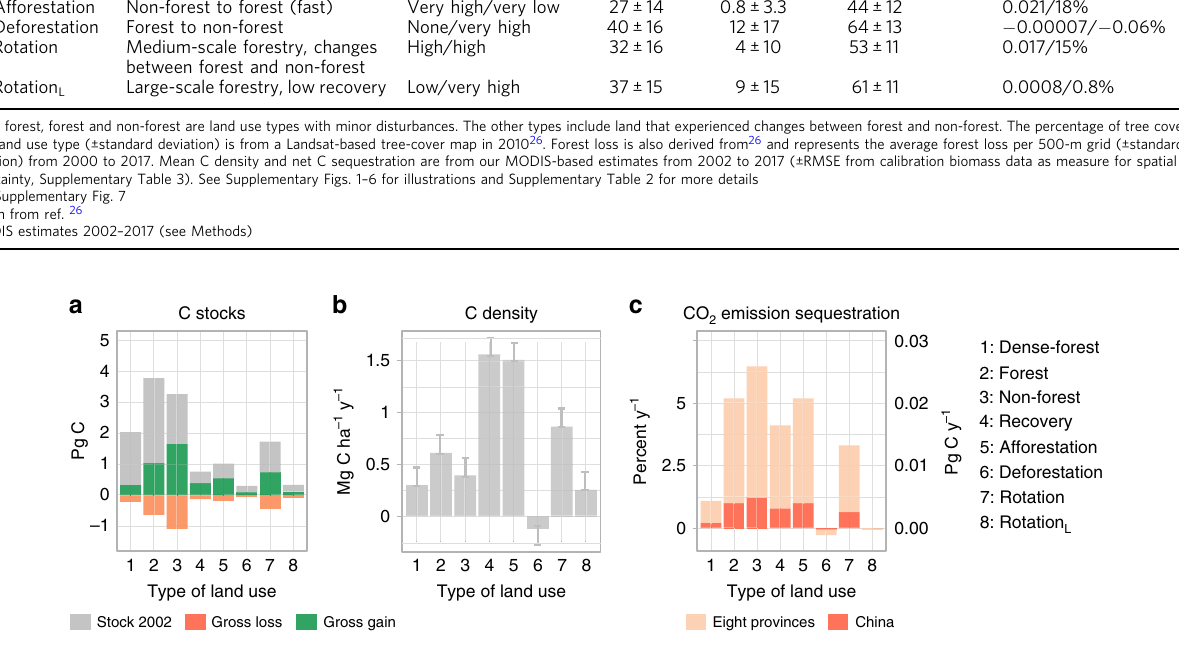
Fig. 3 Dynamics of carbon stocks for different types of land use. a C stocks estimated from MODIS data are shown for the fi rst year of study in 2002 in grey, with consecutive gross gains and losses for 2002 – 2017 in green and orange, respectively. b Net changes in C density (2002 – 2017) from MODIS data. Error bars are the temporal uncertainty based on the RMSE with SMOS estimates. c Annual increase in C stocks for each land use type in Pg C year − 1 on the right-hand axis and as fraction of fossil CO 2 emissions for the eight provinces and for China on the left-hand axis (2002 – 2015). Pixel number for eight provinces = 8,573,649. Source data are provided as a Source Data fi